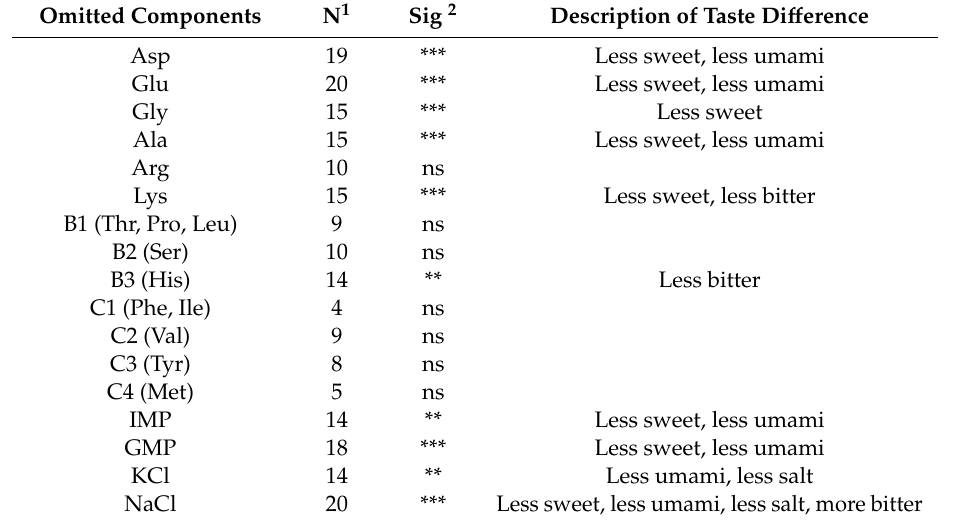
Table 3. Results of the second omission